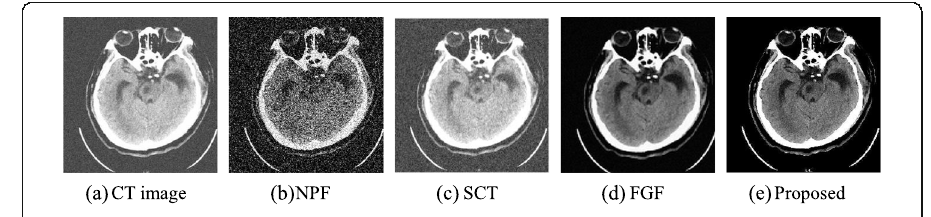
Fig. 5 CT/fusion image of stroke. a CT image. b NPF. c SCT. d FGF. e Proposed